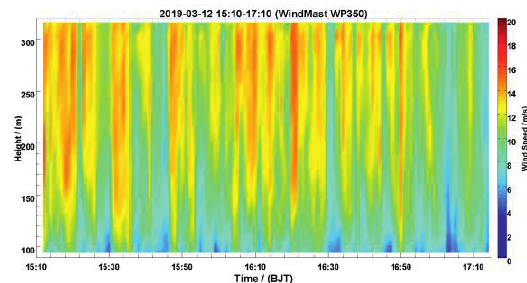
Figure 7. Wind THI diagram from 15:10 to 17:10BJT on 12 March 2019 observed by WP350